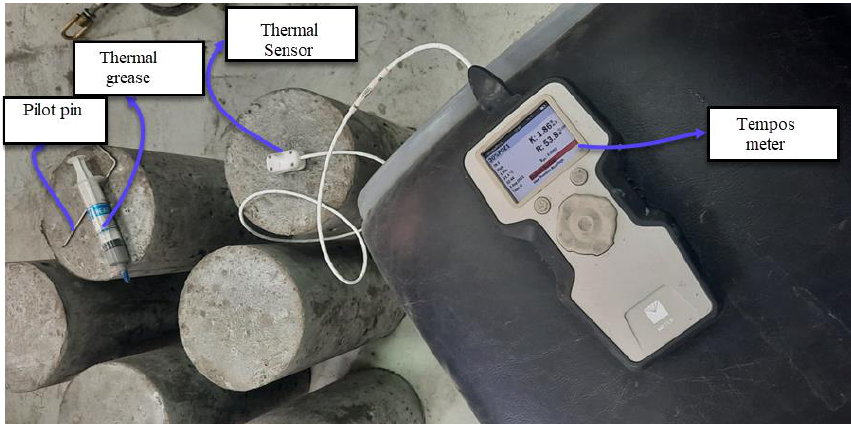
Figure 11. TEMPOS meter for thermal properties of concrete.